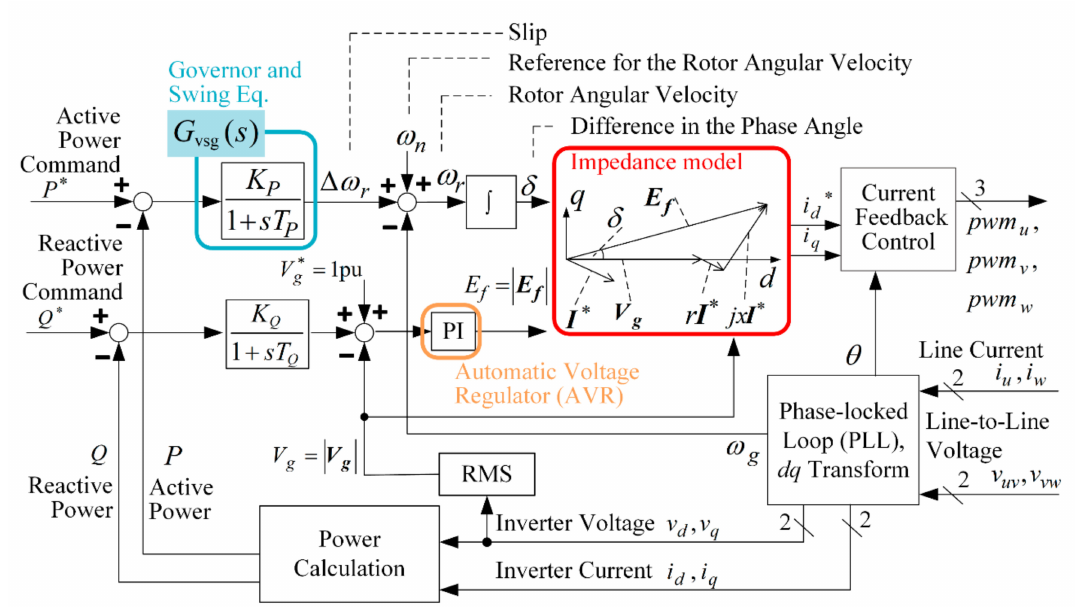
Figure 2. Control block diagram of the Kawasaki virtual synchronous generator